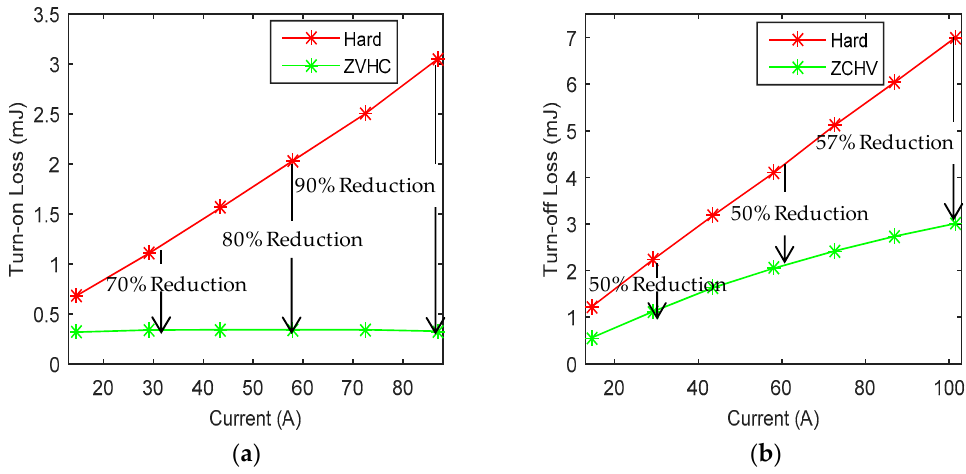
Figure 8. IGBT switching losses comparison during on/off periods ( a ) Turn-on loss; and, ( b ) Turn-off loss.